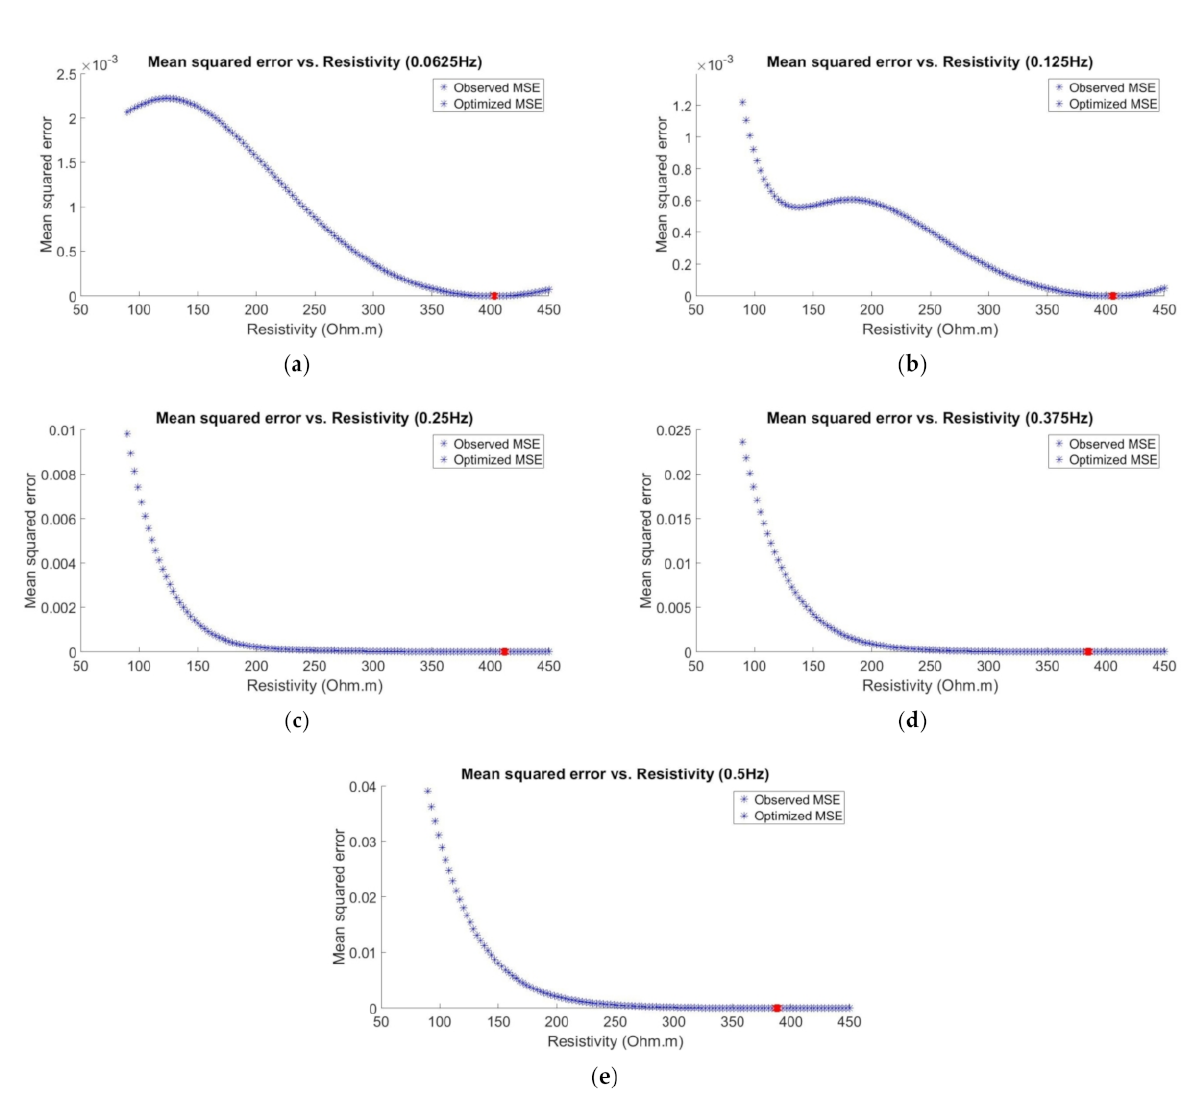
Figure 8. Mean squared error (MSE) versus hydrocarbon resistivity for multiple transmission frequencies (Observational dataset 3 with “unknown” resistivity of 400 Ω m): ( a ) 0.0625 Hz, ( b ) 0.125 Hz, ( c ) 0.25 Hz, ( d ) 0.375 Hz, and ( e ) 0.5